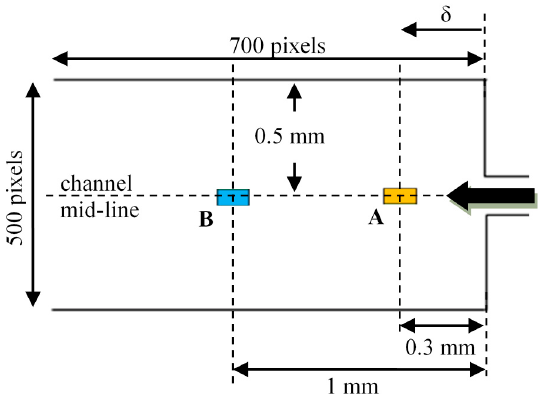
Figure 10. Locations of interrogation windows A and B for single-point velocity measurements.